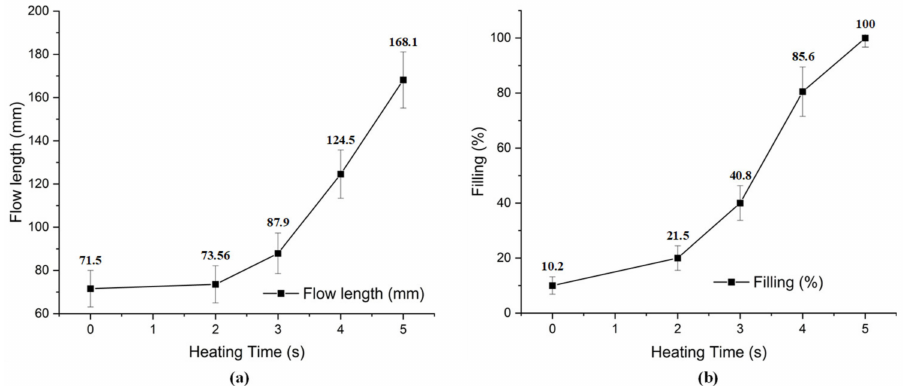
Figure 16. The improvement of melt flow length ( a ) and filling percentage of micro molding product ( b ) when the Ex-IH was